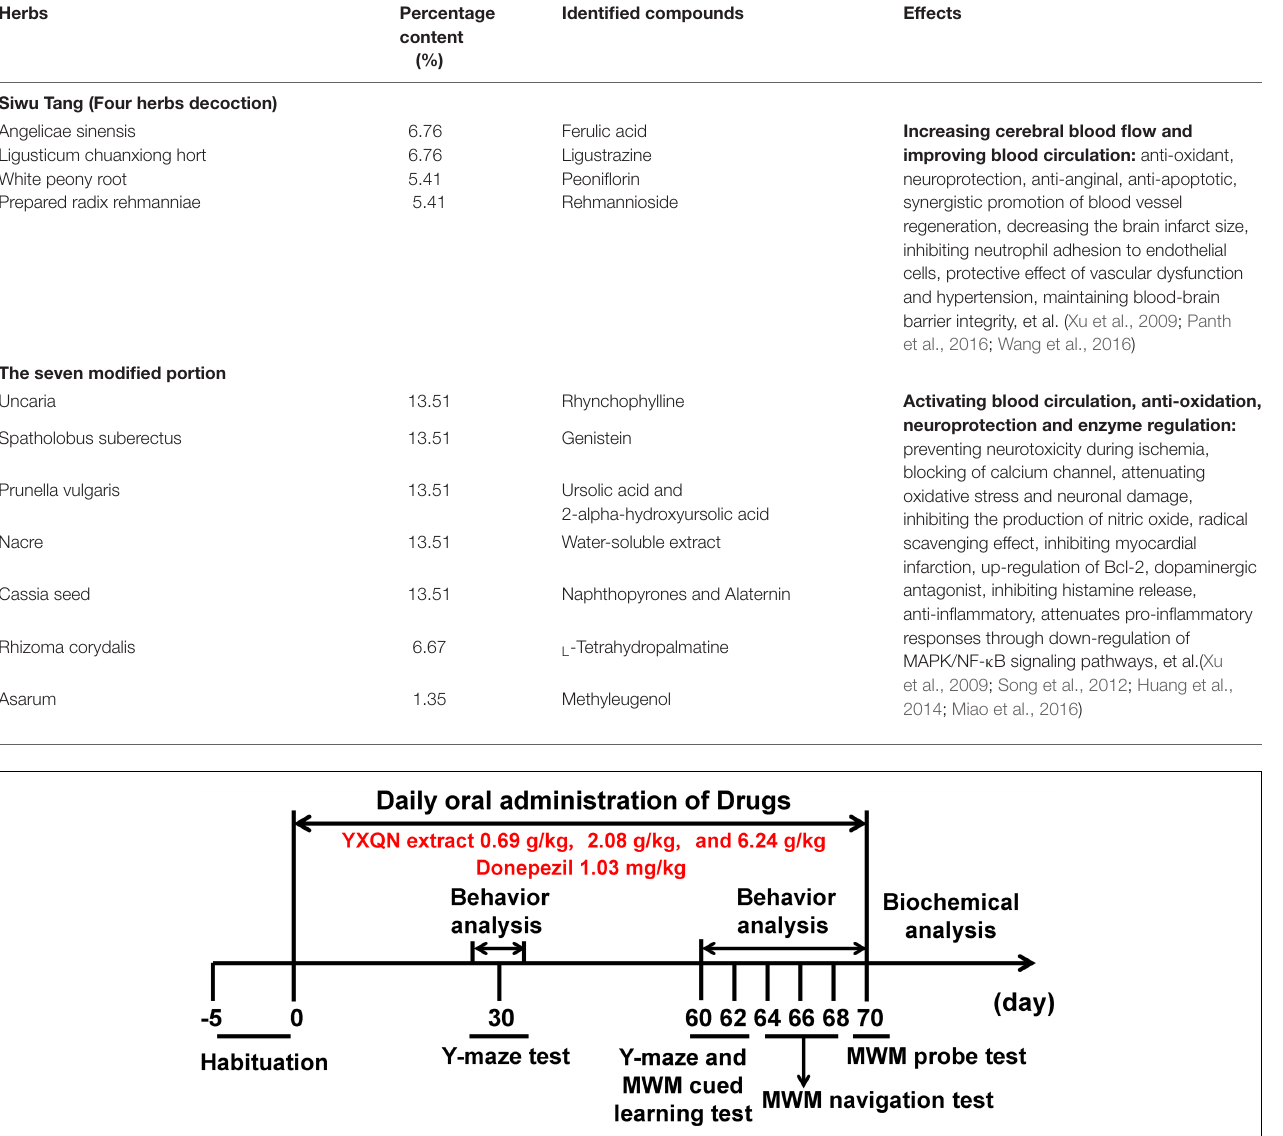
brain was investigated. Therefore, all AD pathological indices in this research were determined in 10-month-old APP/PS1